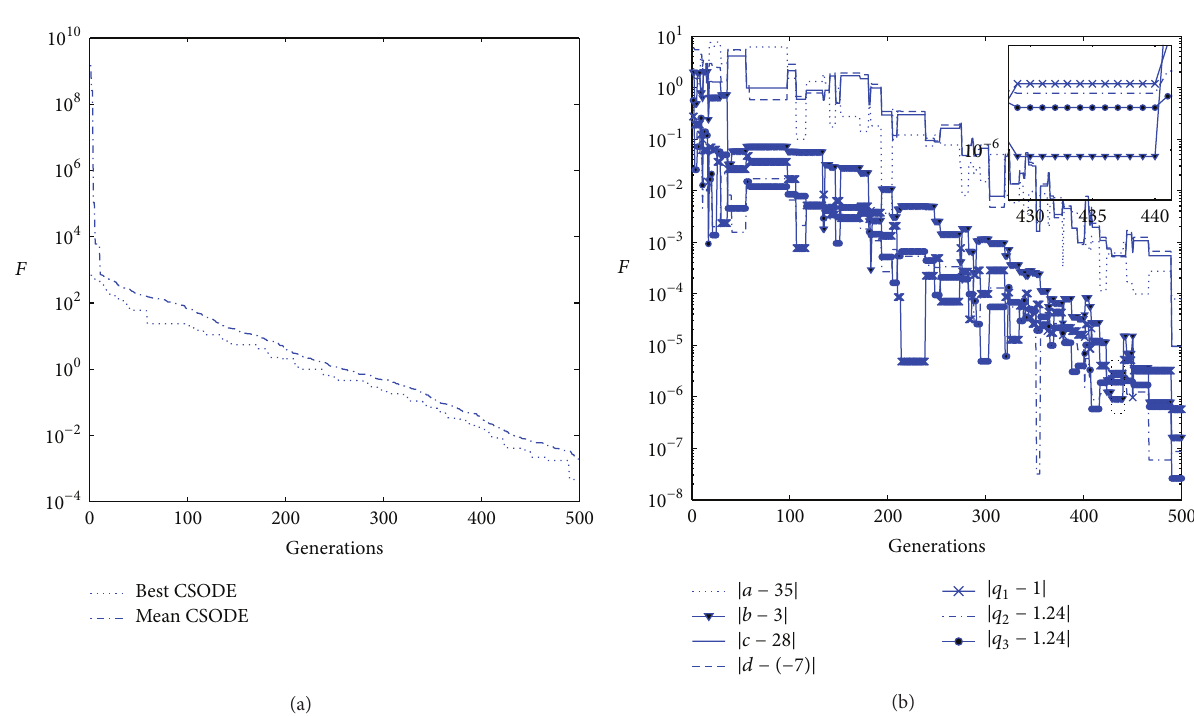
Figure 7: Evolution process for fractional-order improper Chen